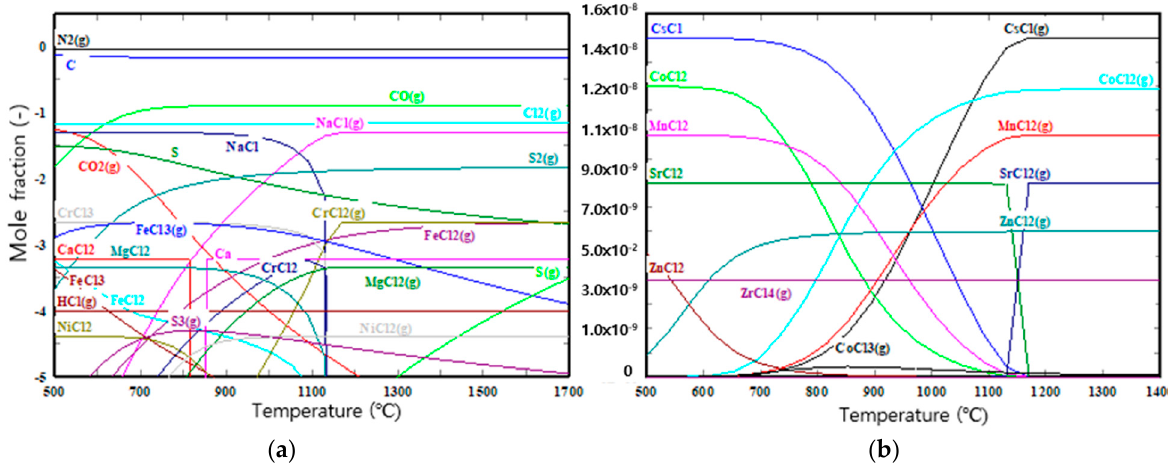
Figure 13. Calculated results for equilibrium mole fractions of nonradioactive compounds ( a ) and radioactive compounds ( b ).